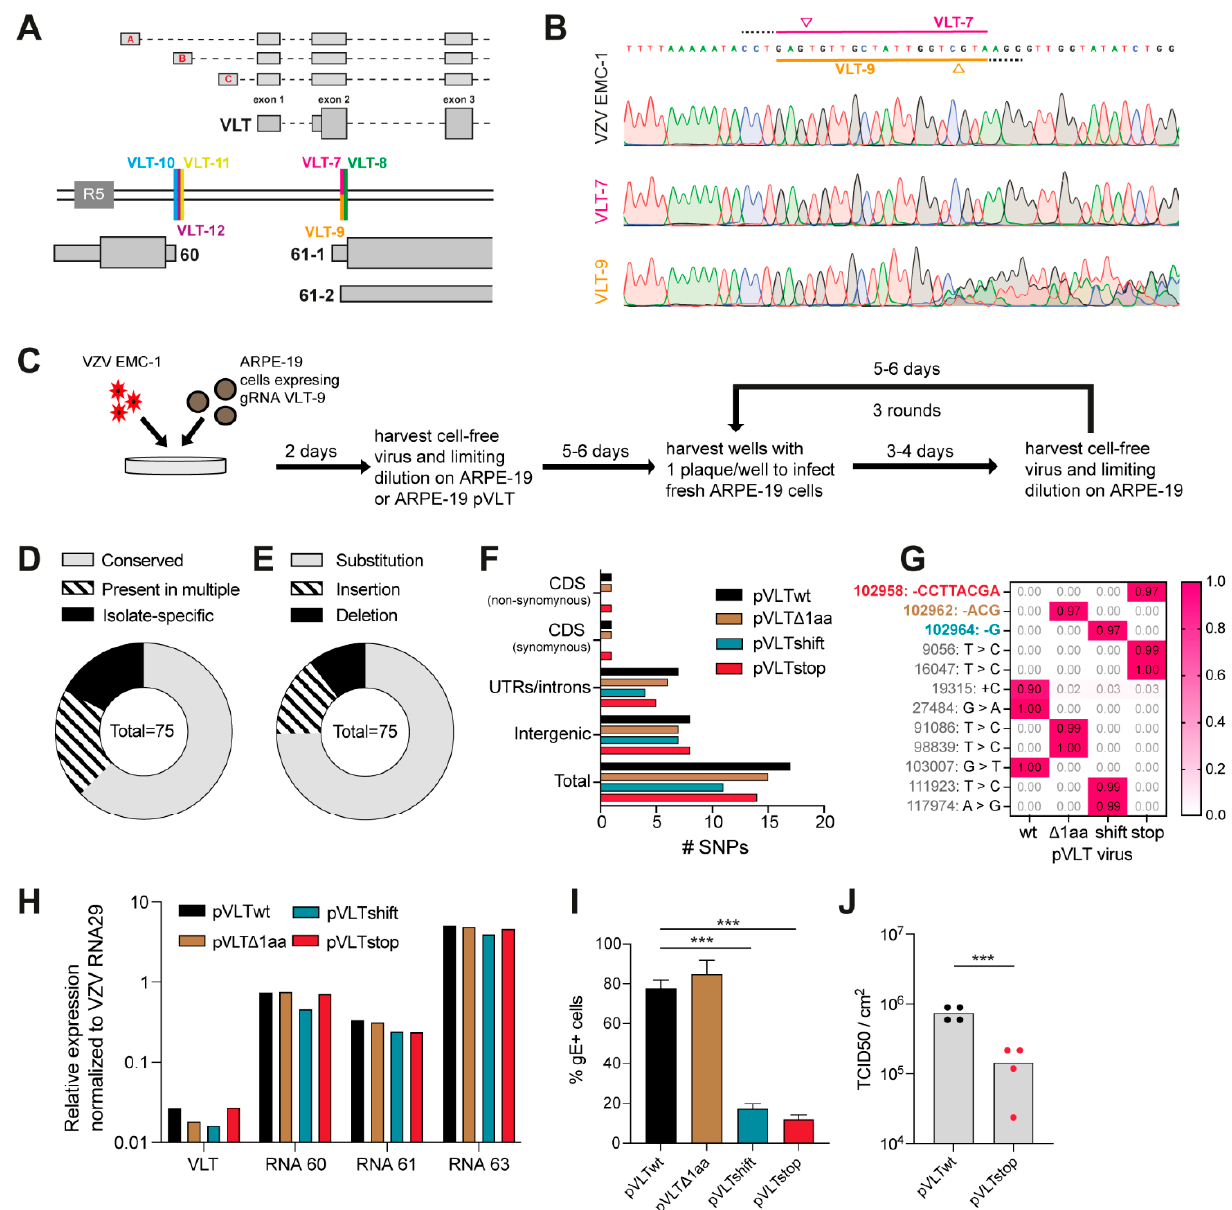
Figure 5. Generation of VZV pVLT/pVLT-ORF63 mutant viruses using a single sgRNA. ( A ) Schematic illustration showing the sgRNA target sites in the VLT region: thick double black lines represent the genome, annotated RNAs are depicted in grey—wide boxes are coding sequences (CDS), thin boxes are untranslated regions (UTRs) and dashed lines are intronic sequences—and the DNA target sites of sgRNAs VLT-7 to VLT-12 are depicted in differentially colored lines. Upper three transcripts represent most abundant alternative upstream exons used during lytic infection—named A-B-C and described in [9]. ( B ) Sanger sequence traces showing the sgRNA VLT-7/VLT-9 target region with PAM sequence (dashed black) and cleavage site (colored triangle) for wild-type VZV EMC-1 DNA (top) or DNA extracted from VZV EMC-1 infected stably transduced VLT-7 cells (middle) and VLT-9 cells (bottom). ( C ) Experimental layout: Stably transduced ARPE-19 cells ex- pressing sgRNA VLT-9 were infected with VZV EMC-1. Two days post-infection, cell-free virus was harvested, and sub- jected to plaque purification on either ARPE-19 or ARPE-19 pVLT cells. Recovered viruses when then purified by three subsequent rounds of plaque purification. ( D – G ) Illumina sequencing of viral DNA of four selected mutant virus isolates identified 75 SNPs compared to reference. ( D ) Distribution of SNPs conserved between all four isolates ( n = 47), SNPs present in multiple isolates ( n = 15) and isolate-specific SNPs ( n = 13). ( E ) Type of SNPs identified in all isolates, substitu- tions ( n = 56), insertions ( n = 11) or deletions ( n = 8). ( F ) Location of SNPs and number of SNPs outside the VLT coding sequence for each mutant viral isolate. ( G ) Proportion of reads of isolate-specific mutations for each mutant viral isolates, with VLT mutations highlighted in bold and colored: pVLT Δ 1aa—brown, pVLTshift—blue and pVLTstop—red. ( H ) Rel- ative expression level of VLT RNAs, RNA 60, RNA 61 and RNA 63 in ARPE-19 cells asynchronously infected with either